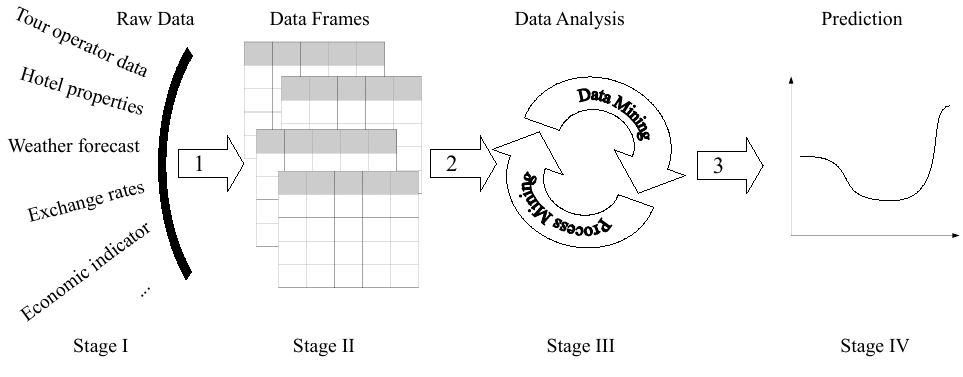
Figure 1. Stages of the ePredyktour